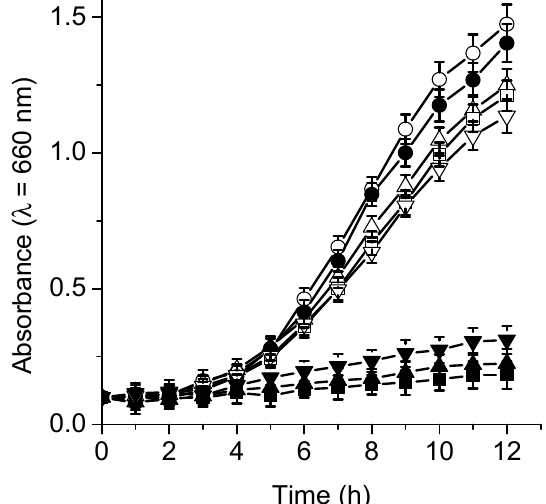
Figure 9. Growth curves of C. albicans treated with 5 µ M TPCF 16 ( ▲ ), ZnTPCF 16 ( ■ ), and PdTPCF 16 ( ▼ ) and irradiated with white light for different irradiation times at 37 °C. Controls: cells untreated with PS and irradiated ( • ), C. albicans untreated with PS in the dark ( # ), cells treated with 5 µ M TPCF 16 ( △ ), ZnTPCF 16 ( ~ ), and PdTPCF 16 ( ▽ ) in the dark.